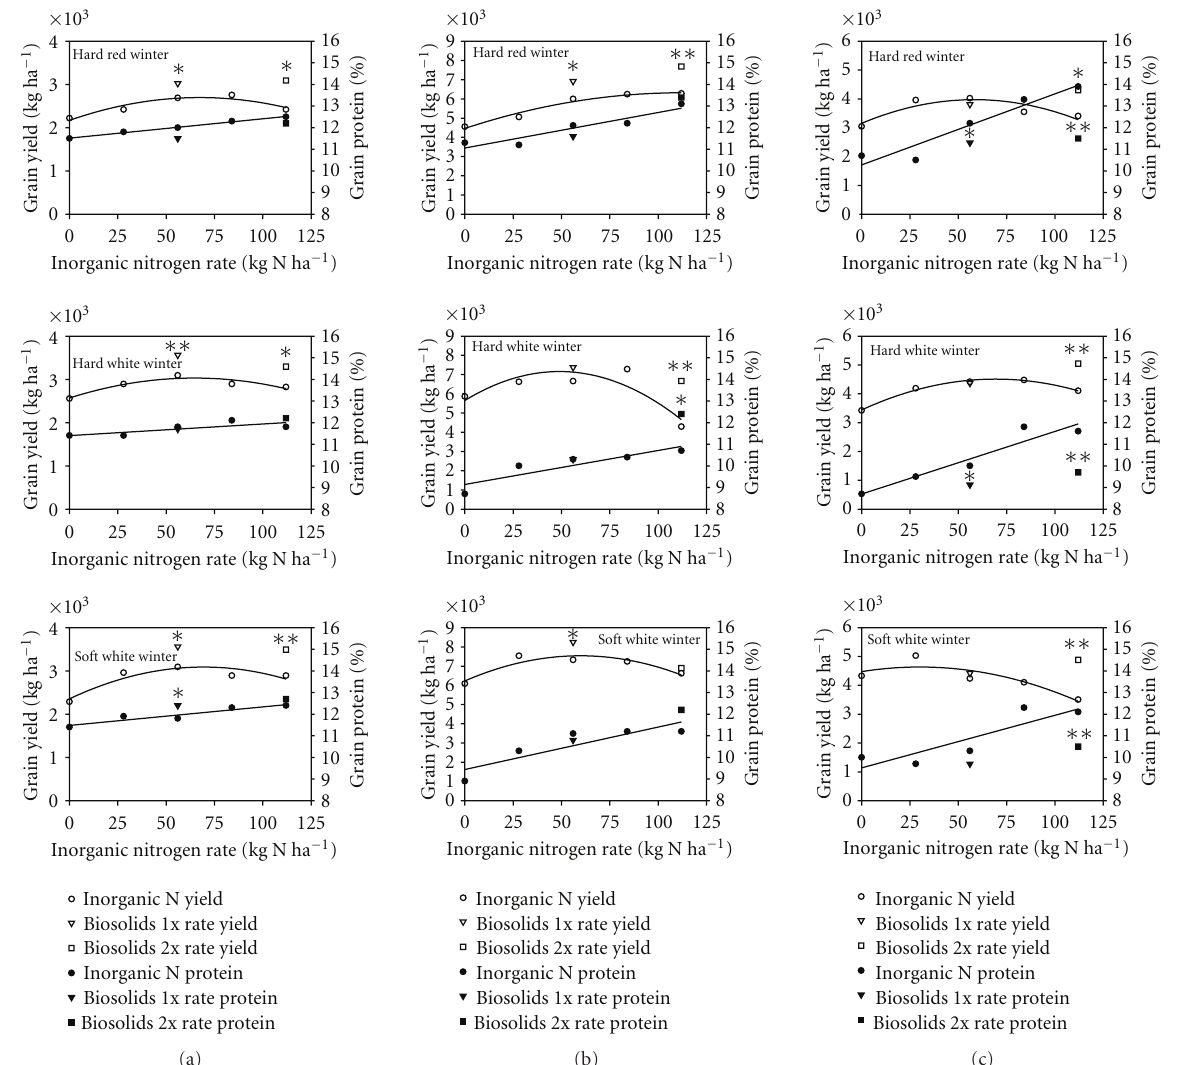
Figure 1: The e ff ect of inorganic N fertilizer and biosolids on yield and grain protein content of three wheat market classes at Lind (a), Davenport (b), and Pullman (c), Wash in 2007. The horizontal axis (N rate) is the same for each graph panel. Due to large di ff erences in grain yield, the vertical axis changes for each market class site (column). Where indicated by the regression line, quadratic or linear responses are significant at P < . 05. ∗ and ∗∗ indicate significant di ff erences at the 0.10 and 0.05 level, respectively, between inorganic N and biosolids treatments at that inorganic nitrogen and biosolids